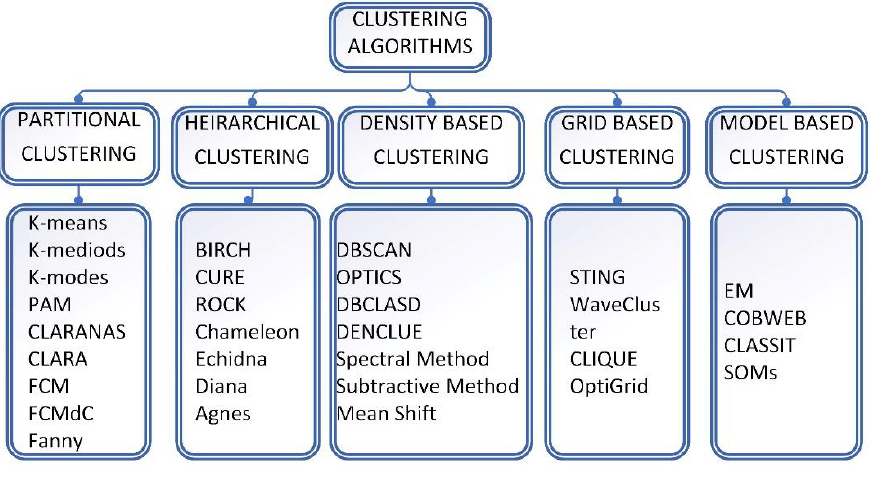
Figure 2. Clustering algorithms